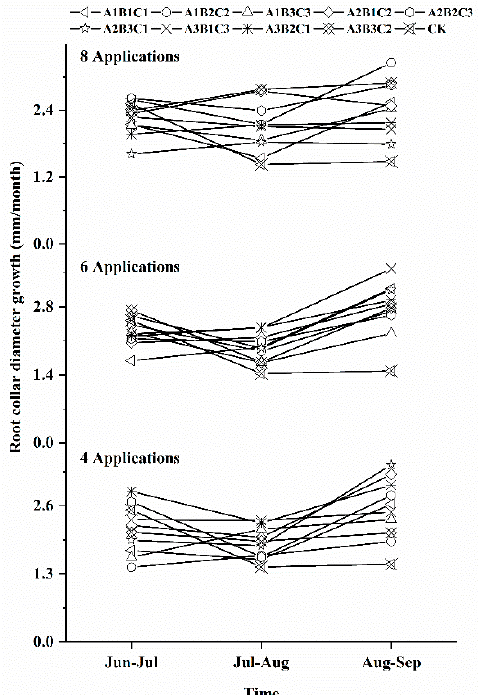
Figure 2. Dynamic changes in seedling root collar diameter growth under different fertilization ratios and frequencies.